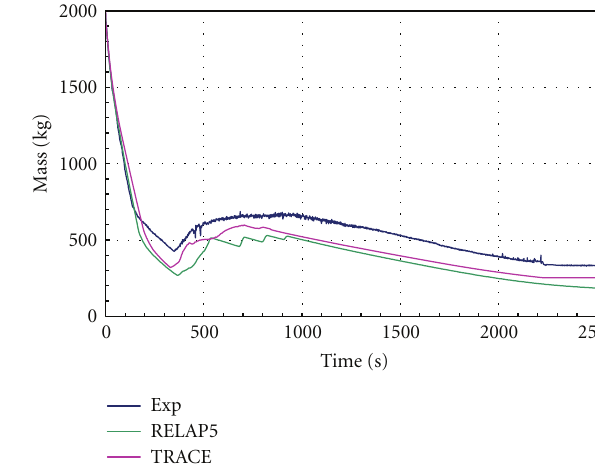
Figure 10: Heater rod surface temperature at the middle of the core.